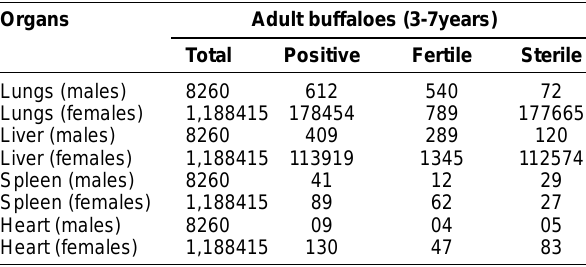
Table-4 number of cysts recovered with their fertility rate in Adult